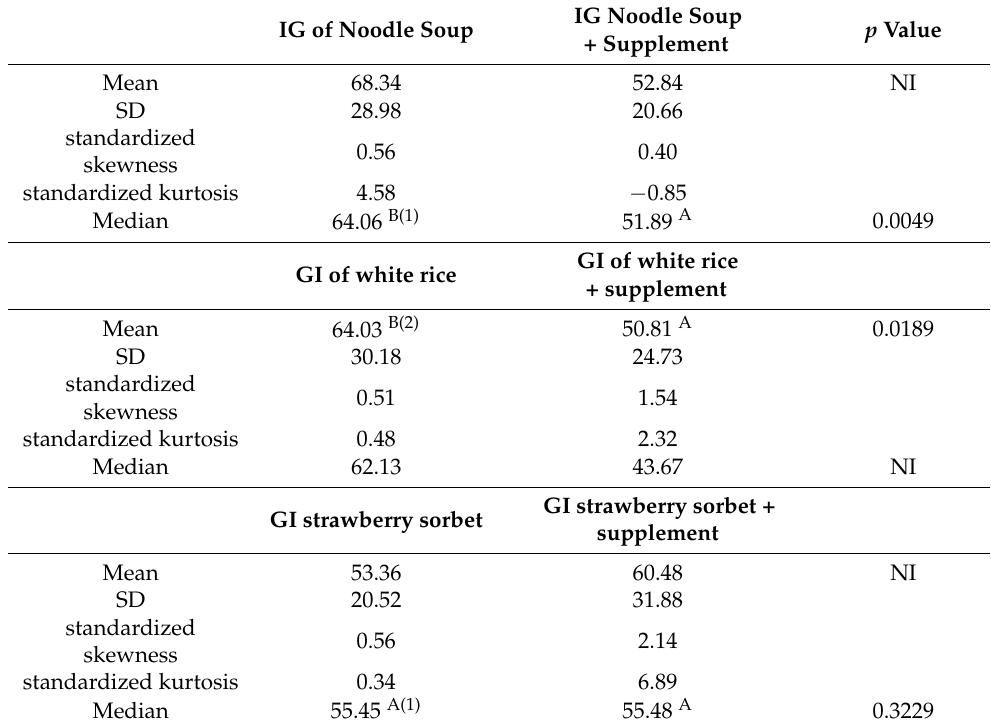
Table 5. Glycemic index of the tested products without and with the addition of the plant-based formula ( n = 23).